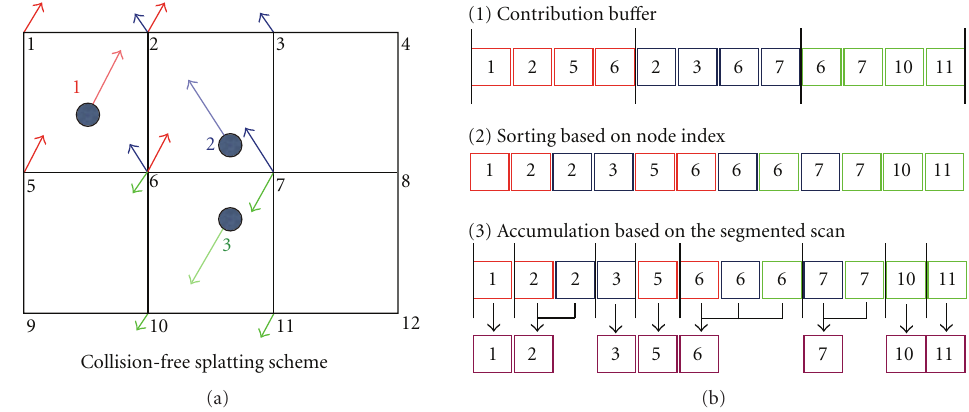
Figure 6: Collision-free splatting implementation using fast parallel sorting. The method is based on ordering the node contribution ID to resolve resource conflicts which allows a parallel e ffi cient integration based on an optimal parallel prefix scan implementation.